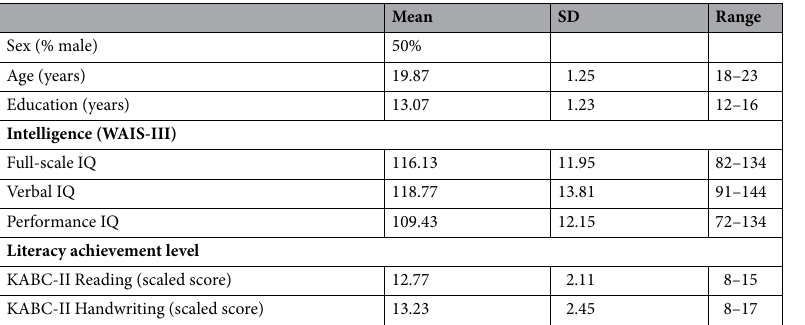
Table 1. Demographic characteristics, intelligence, and literacy achievement level of participants. Note: n = 30. SD standard deviation, WAIS-III Wechsler Adult Intelligence Scale, third edition, IQ intelligence quotient, KABC-II Kaufman Assessment Battery for Children, second edition, the mean IQ ± SD of the WAIS-III is 100 ± 15, the mean scaled score ± SD of KABC-II is 10 ±